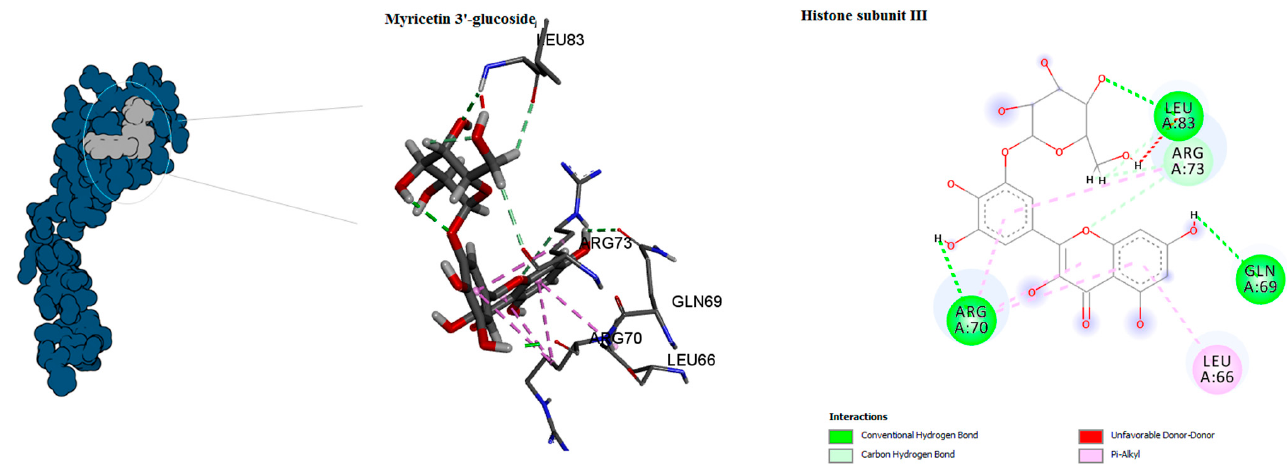
Figure 7. Predicted binding mode for histone subunit III with myricetin 3 ′ -glucoside ID.